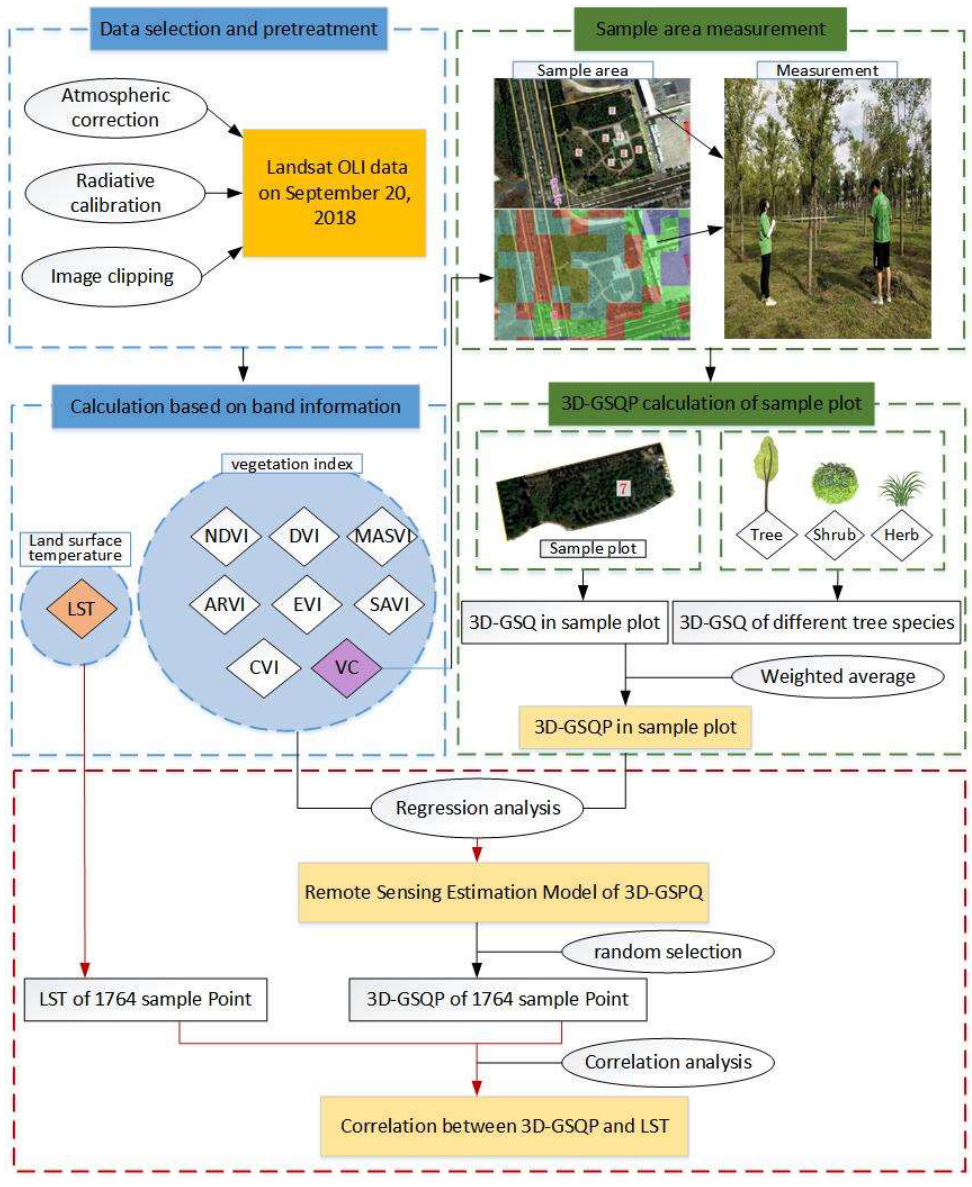
Figure 2. Data processing flow chart in this study.